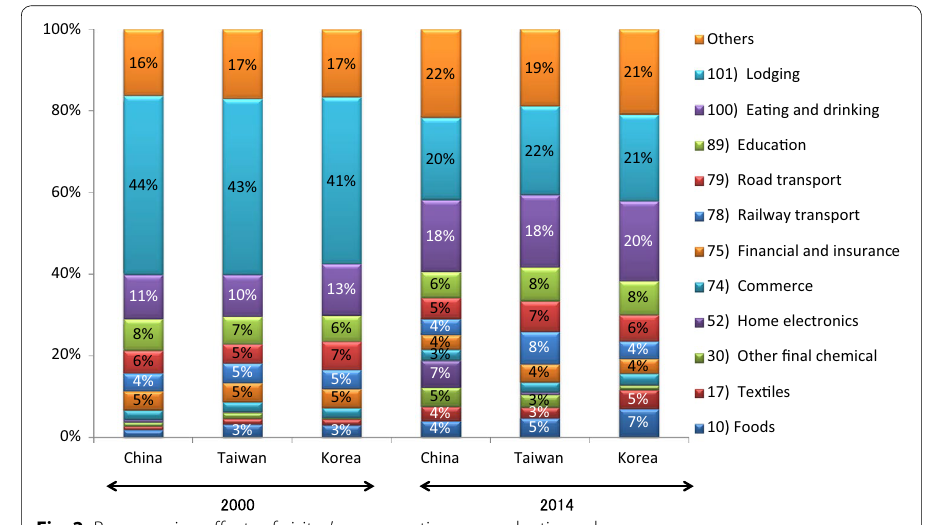
Fig. 2 Repercussion effects of visitor’s consumption on production value